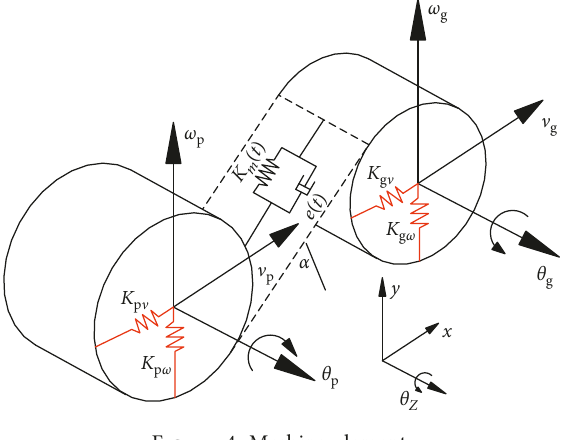
Figure 4: Meshing